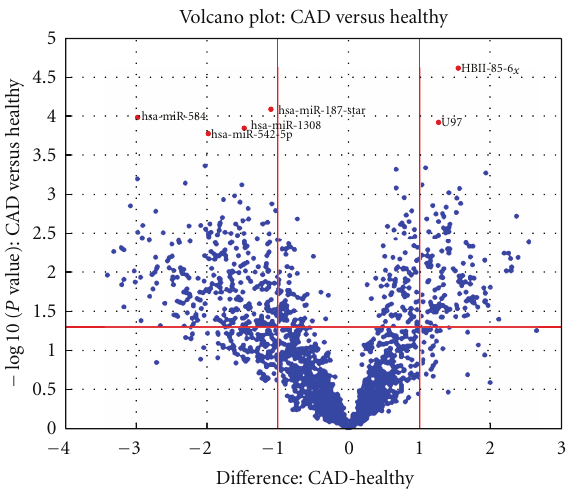
Figure 1: Volcano plot of all pairwise comparisons. Comparisons of all small RNAs assessed in microarray analysis of RNA isolated from blood of patients with CAD ( n = 5) or healthy volunteers ( n = 5). The volcano plot displays the relationship between fold-change and significance between the two groups, using a scatter plot view. The y -axis is the negative log10 of P values (a higher value indicates greater significance) and the x -axis is the di ff erence in expression between two experimental groups as measured in glog2 space . Probes identified as significant are labeled on the plot ( FDR t-test <